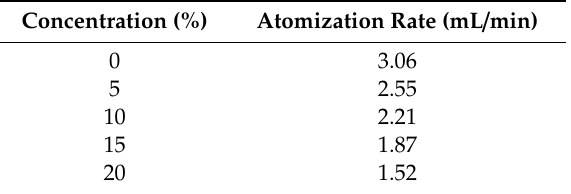
Figure 14. Relationship between the atomization rate and liquid concentration. Table 6. Atomization rates at di ff erent concentrations of NaCl